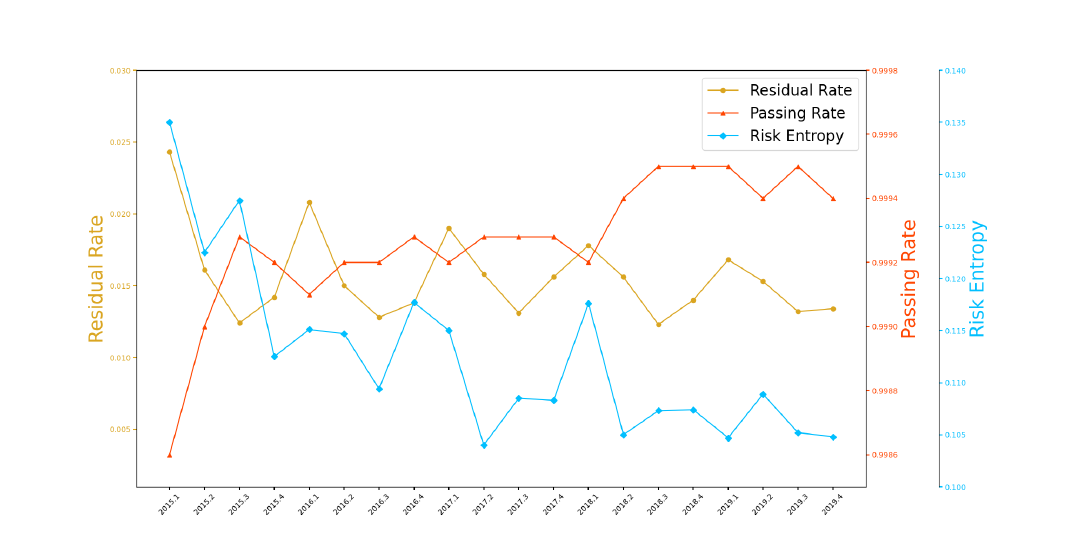
Figure 6. Overall evaluation.